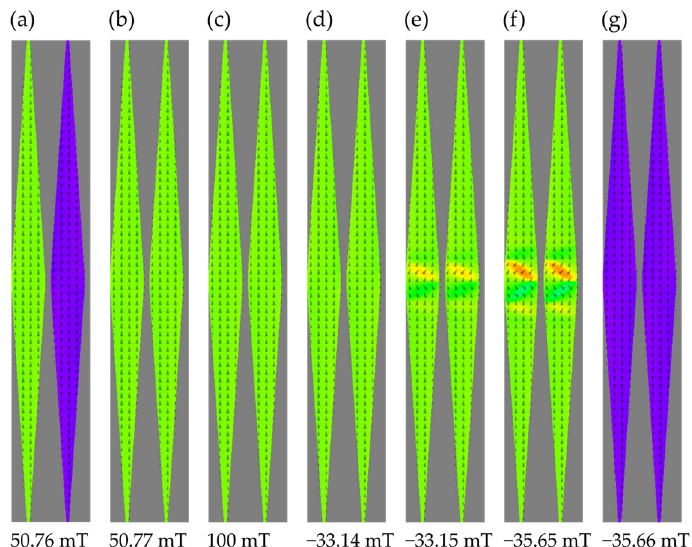
Figure 5. Magnetization maps for a pair of macrospins at the separation distance d = 60 nm. ( a , b ) just before and just after the AF → FM switching, ( c ) at the largest applied field, ( d – g ) consecutive stages of the FM → rFM switching. Intensity of the applied field is given below each panel.